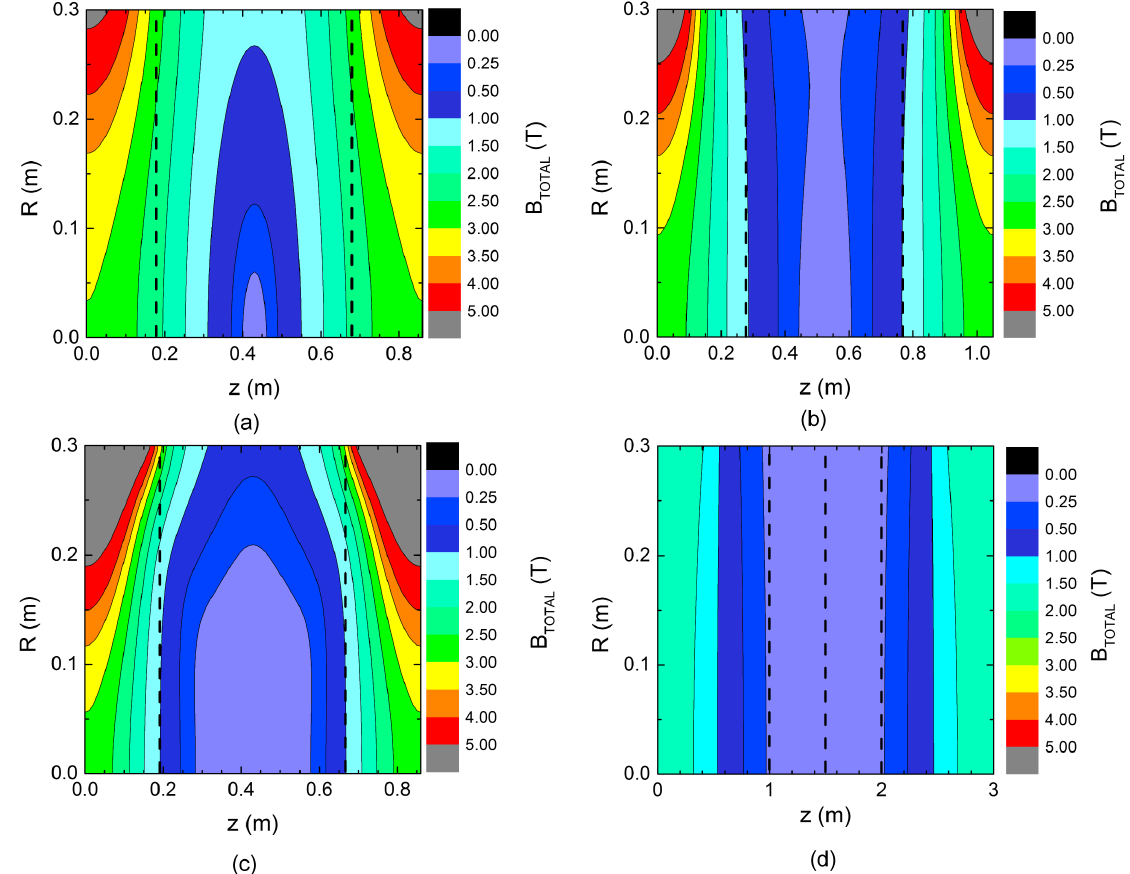
FIG. 5. Color map plot of the total magnetic distribution, B (c) LCB lattice, and (d) ICL lattice. Dashed line indicates the position of the wall of the rf